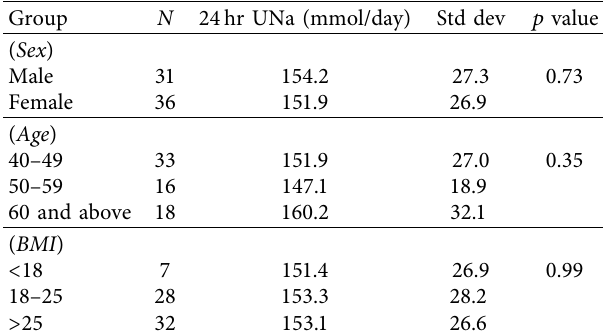
Table 2: 24hr urinary sodium excretion (UNa) stratified by sex, age, and BMI.